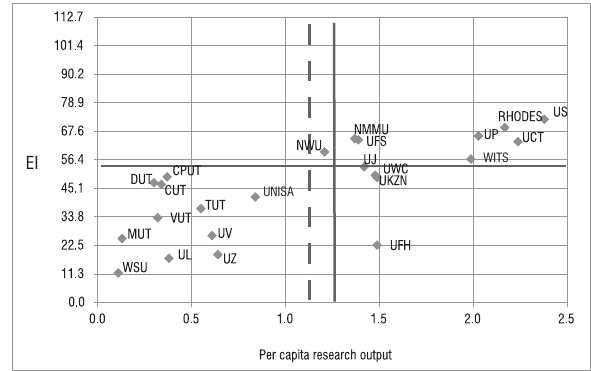
The 2011 total weighted research productivity versus the instructional/research professional staff Equity Index ( n =8).